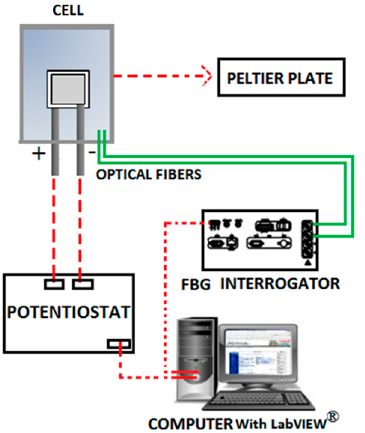
Figure 2. Experimental setup diagram.